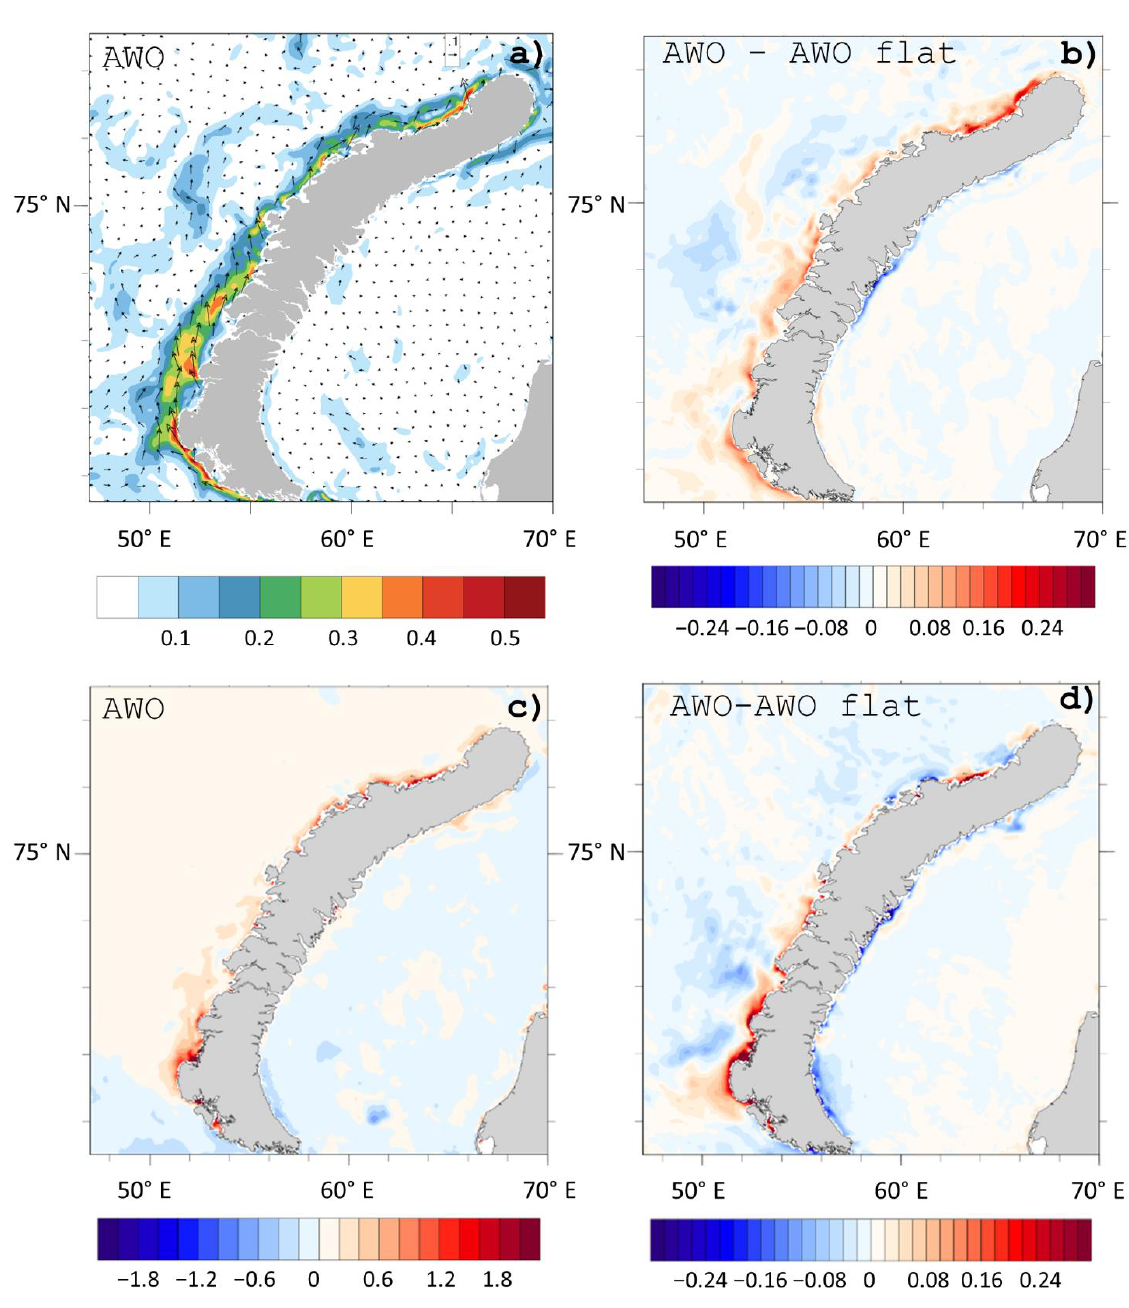
Figure 9. Depth-averaged current speed (m s −1 ) ( a ), difference in current speed (m s −1 ) between “AWO” and “AWO flat” experiment ( b ), change of water density (kg m −3 ) during bora ( c ) and difference in water density (kg m −3 ) between “AWO” and “AWO flat” experiment s ( d ) averaged over the bora period (10 – 12 December).